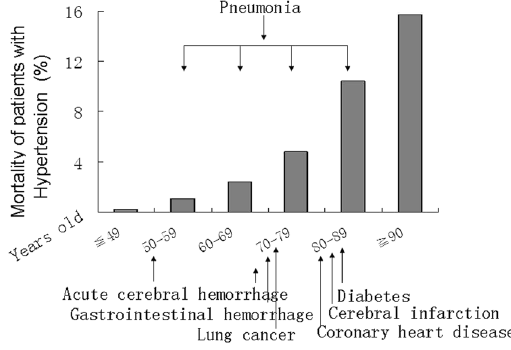
Figure 5. Risk factors associated with the mortality of women with hypertension in different age groups. Diseases, which are pointed in the figure, are risk factors associated with the mortality corresponding to different age